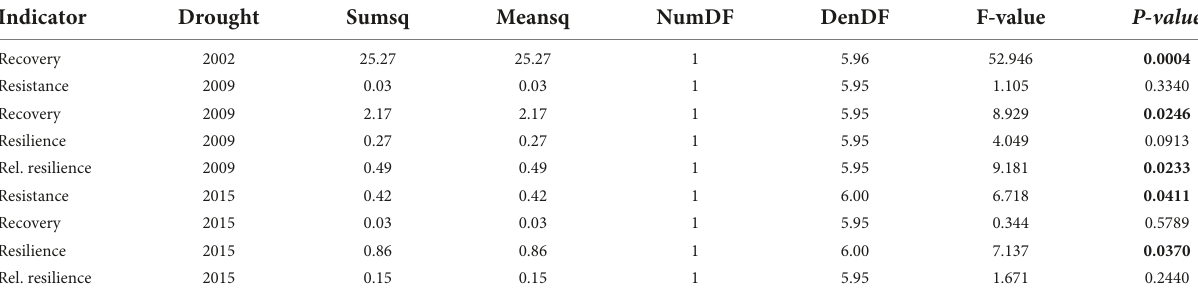
TABLE 1 Anova table for treatment effects after a mixed model analysis of drought indicator indices. These were calculated as relative changes in basal area increments before, during, and after drought events in 2009, and 2015. Because the partial cutting treatment occurred after the 2002 growing season, only the basal area increments during and after the drought of 2002 were used to calculate the recovery index. Tested groups are no-harvest control, and 25% retention of basal area per ha.